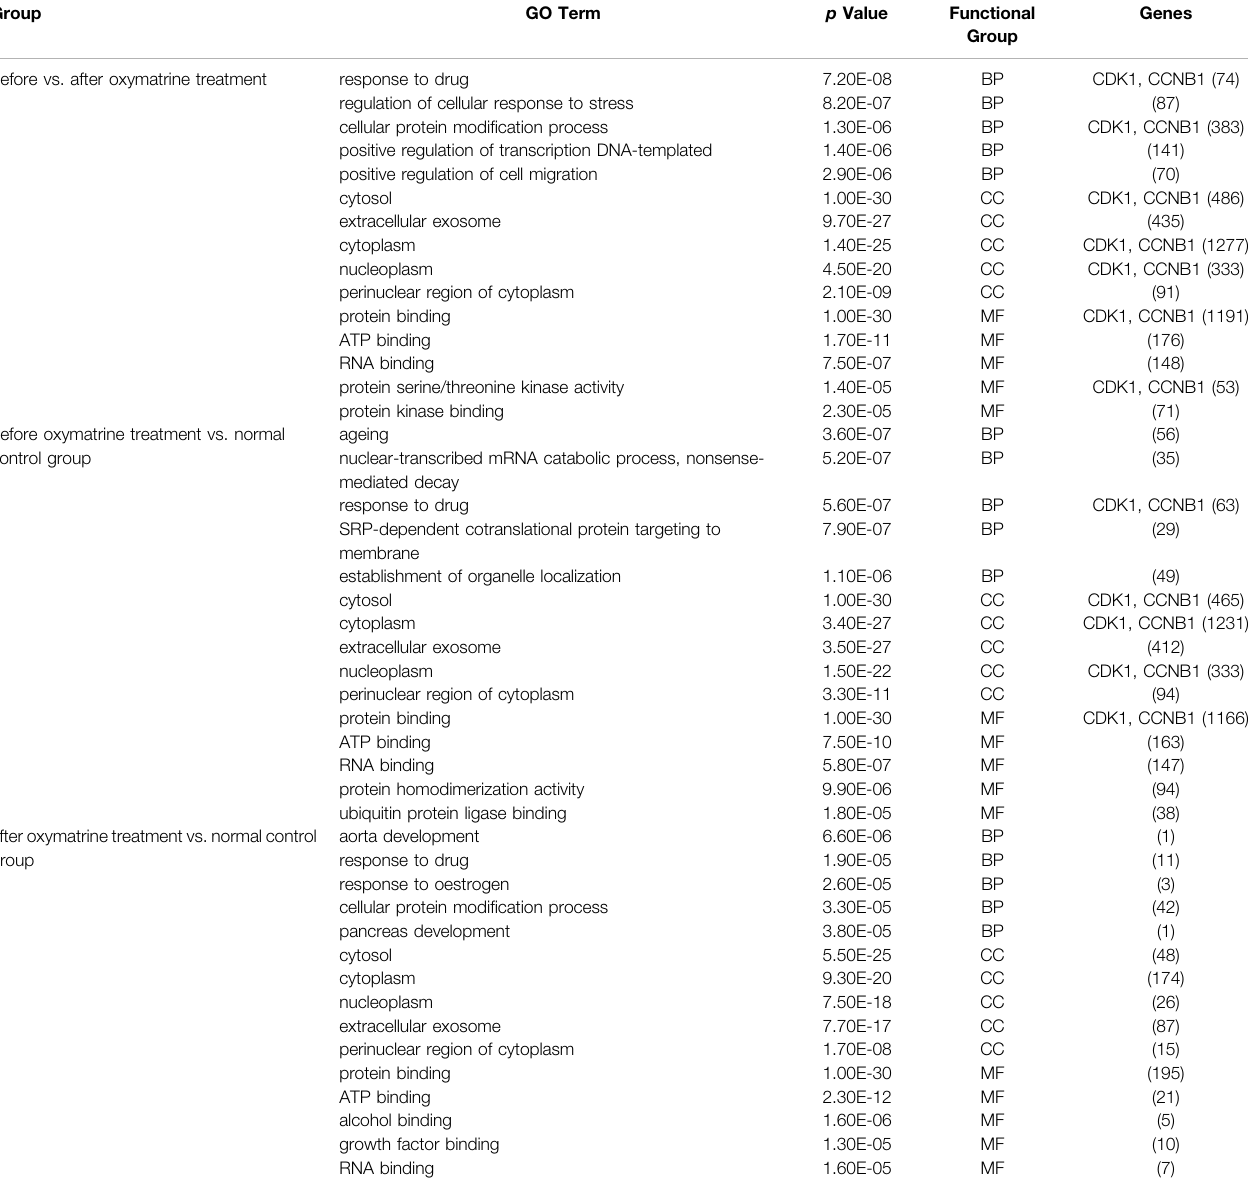
TABLE 1 | GO analysis.